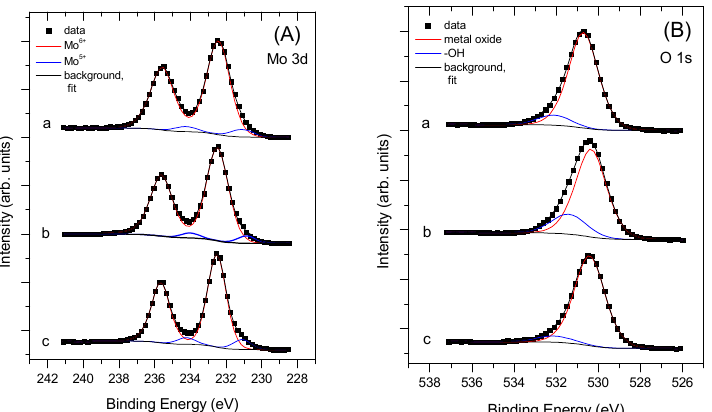
Figure 1. Panel ( A ): Mo 3d and Panel ( B ): O 1s spectra of the untreated ( a ), 200 °C ( b ), and 300 °C ( c ) annealed sputtered Mo-oxide films.